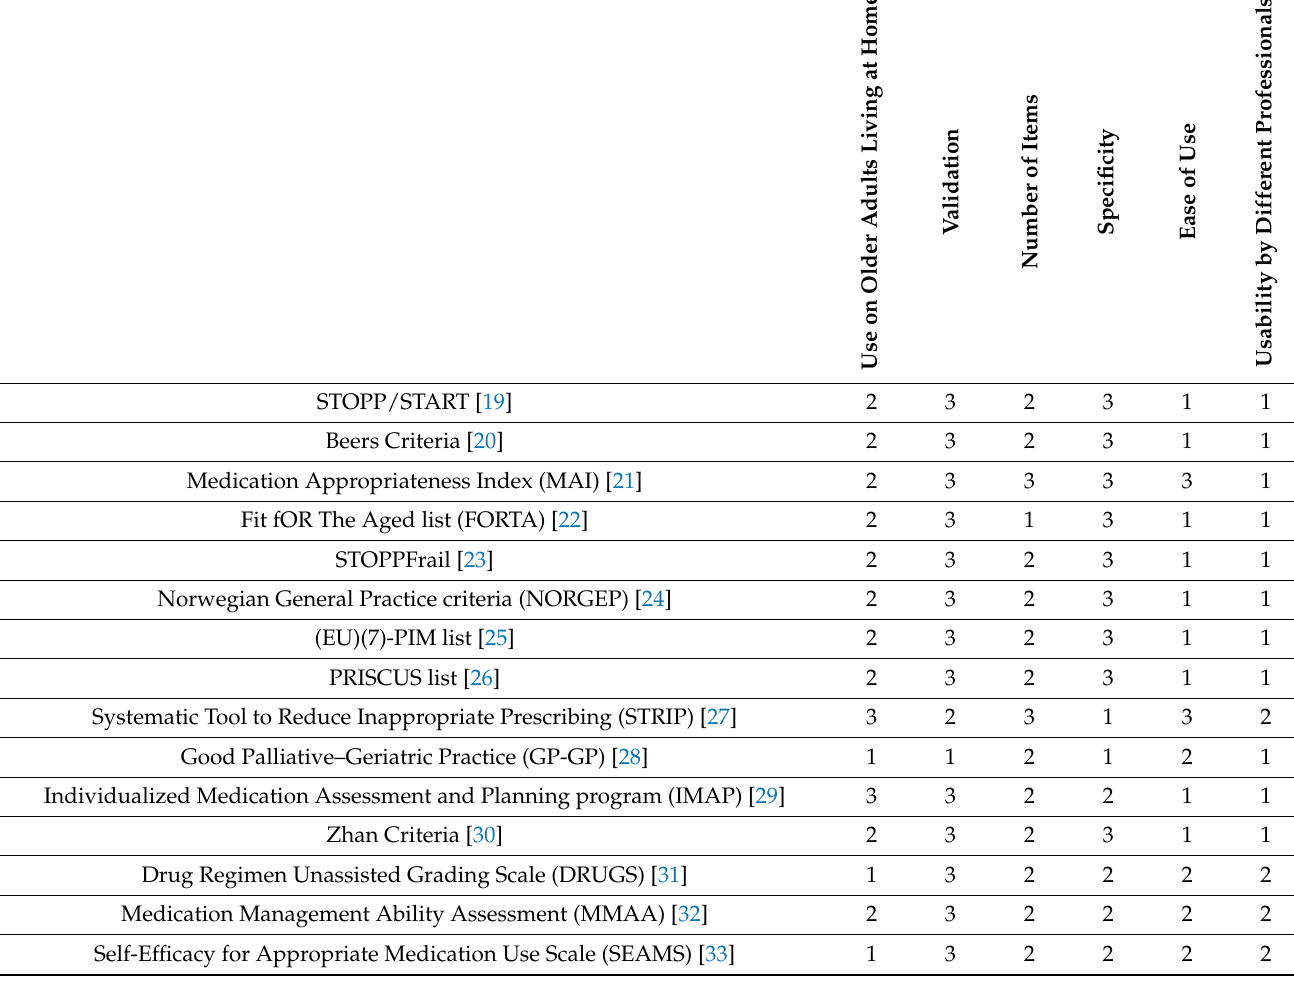
Table 2. Prescription appropriateness and adherence assessment tools